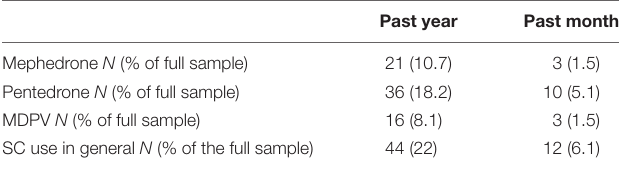
TABLE 2 | Self-reported past year and past month SC use.